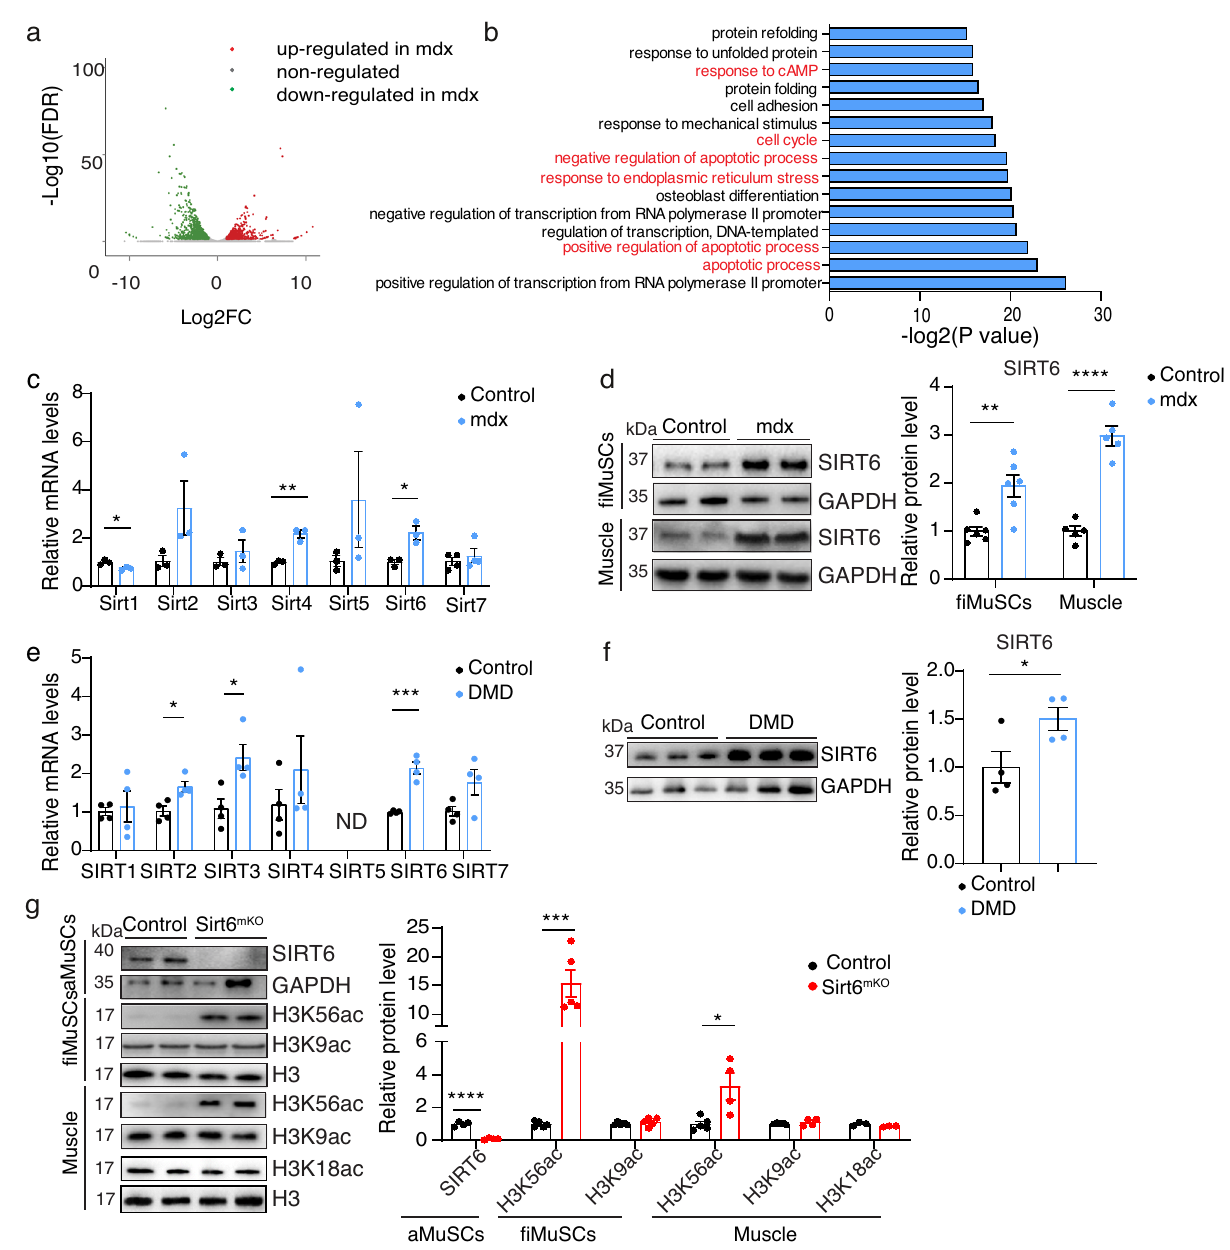
Fig. 1 SIRT6 is upregulated in muscle cells of mdx mice and controls H3K56ac levels. a Volcano plot of differential expressed genes in freshly isolated MuSCs from wild-type and mdx mice. The vertical axis ( y -axis) corresponds to the mean expression value of log10 (FDR), and the horizontal axis ( x -axis) displays the log2-fold change value. Red dots represent upregulated transcripts in mdx mice; green dots represent downregulated transcripts. Benjamini- Hochberg test, two-sided. b Top 15 biological processes (BP) deregulated in mdx versus wild type MuSCs. Fisher ’ s exact test, two-sided. c RT-qPCR analysis of sirtuin expression in freshly isolated MuSCs ( fi MuSCs) from wild type mice (hereafter referred to as control) and mdx mice. m36b4 was used as a reference gene. (* p = 0.0235, ** p = 0.0024, * p = 0.0136; Sirt1-6: n = 3; Sirt7 : n = 4). d Western blot analysis of SIRT6 expression in freshly isolated MuSCs ( fi MuSCs) and muscle tissues from control and mdx mice. GAPDH was used as loading control. Quanti fi cation of protein bands are shown on the right (** p = 0.0037, **** p < 0.0001; fi MuSCs n = 6; muscle n = 5). e RT-qPCR analysis of expression of different sirtuins in myoblasts derived from healthy (referred to as control) and DMD patients (* p = 0.0145, * p = 0.0192, *** p = 0.0003; n = 4). ND non-detectable levels. f Western blot analysis of SIRT6 expression in myoblasts derived from control and DMD patients. GAPDH was used as loading control. Quanti fi cation of protein bands are shown on the right (* p = 0.0484; n = 4). g Western blot analysis of SIRT6 level in proliferating MuSCs isolated from WT and Sirt6 mKO mice 3 days after in vitro culture (ASCs). H3K56ac, H3K9ac, and H3K18ac levels in freshly isolated MuSCs ( fi MuSCs) and in muscle tissues from WT and Sirt6 mKO mice are shown as well. GAPDH or Histone H3 was used as loading control. Quanti fi cation of protein bands are shown in the right (**** p < 0.0001; *** p = 0.0003; * p < 0.0167, Sirt6: n = 4; H3K56ac, H3K9ac: n = 5; H3K18ac: n = 3). For c – g unpaired two-tailed t -test. Males, 8 – 12 weeks old were used. Data are presented as mean ± SEM ( c – g ). Source data are provided in the Source Data fi le.